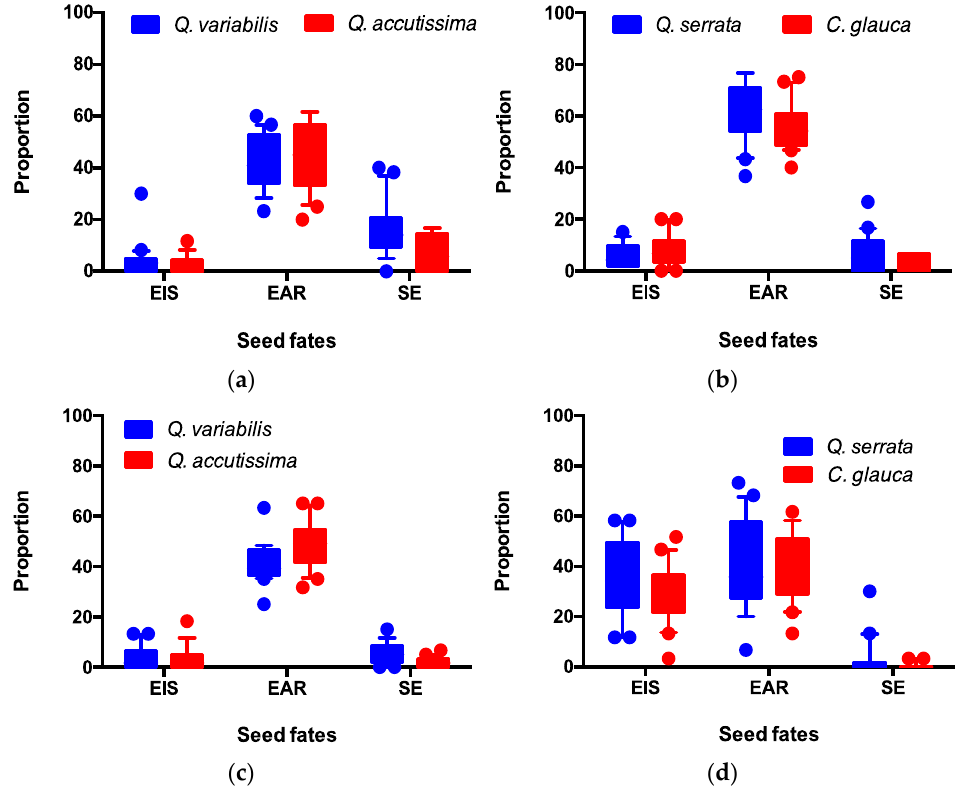
Figure 3. Seed fates of Q. variabilis and Q. accutissima ( a ), Q. serrata and C. glauca in a masting year ( b ) as well as Q. variabilis and Q. accutissima ( c ), Q. serrata and C. glauca in a non-masting year ( d ). EIS, EAR, and SE indicate acorns eaten in situ, eaten after removal, and seedling establishment from the released acorns, respectively.